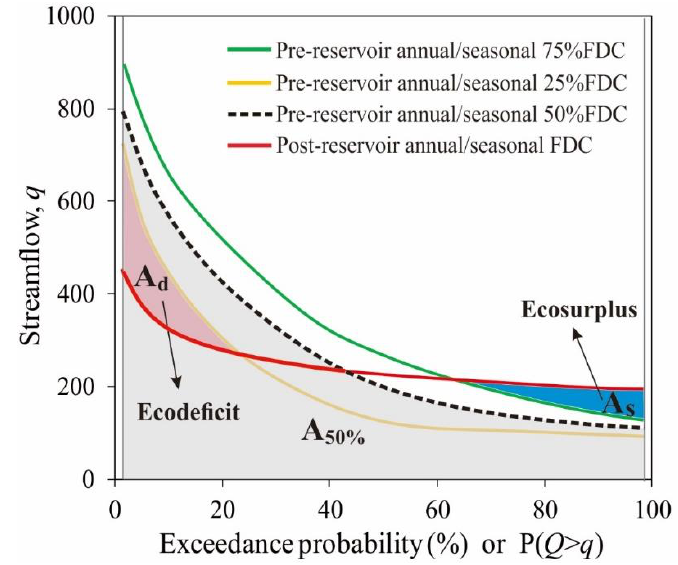
Figure 3. Schematic diagram of the definitions of ecosurplus and ecodeficit.